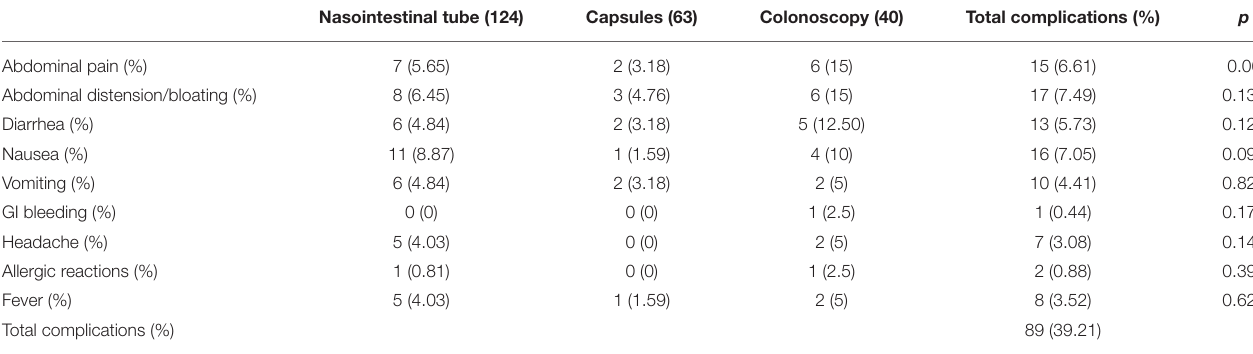
TABLE 3 | Side effects of